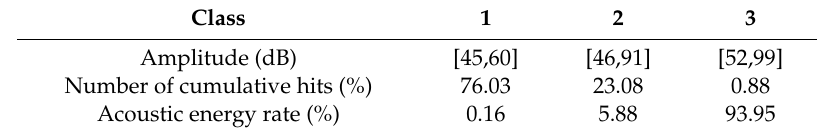
Figure 14. ( a ) Representation of events in amplitude/deformation, ( b ) cumulative acoustic energy of the different classes for the 45° specimen types. Table 6. Distribution of the parameters of the damage classes for the 45° specimens.